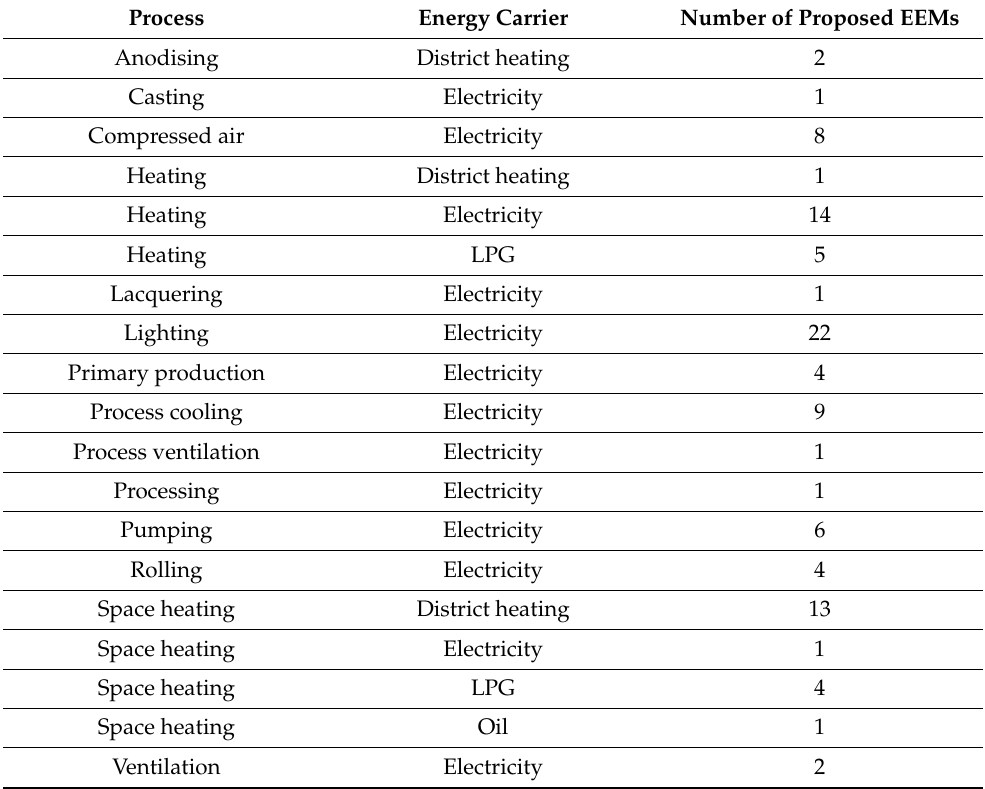
Table 2. An overview of the studied EEMs. In total, 100 EEMs were studied for four different energy carriers. Only processes with at least one proposed efficiency measure are shown in the table. Process Energy Carrier Number of Proposed EEMs Anodising District heating 2 Casting Electricity 1 Compressed air Electricity 8 Heating District heating 1 Heating Electricity 14 Heating LPG 5 Lacquering Electricity 1 Lighting Electricity 22 Primary production Electricity 4 Process cooling Electricity 9 Process ventilation Electricity 1 Processing Electricity 1 Pumping Electricity 6 Rolling Electricity 4 Space heating District heating 13 Space heating Electricity 1 Space heating LPG 4 Space heating Oil 1 Ventilation Electricity